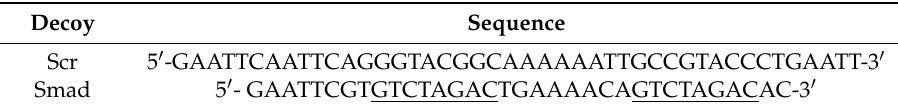
Table 1. Sequences of decoy used in this